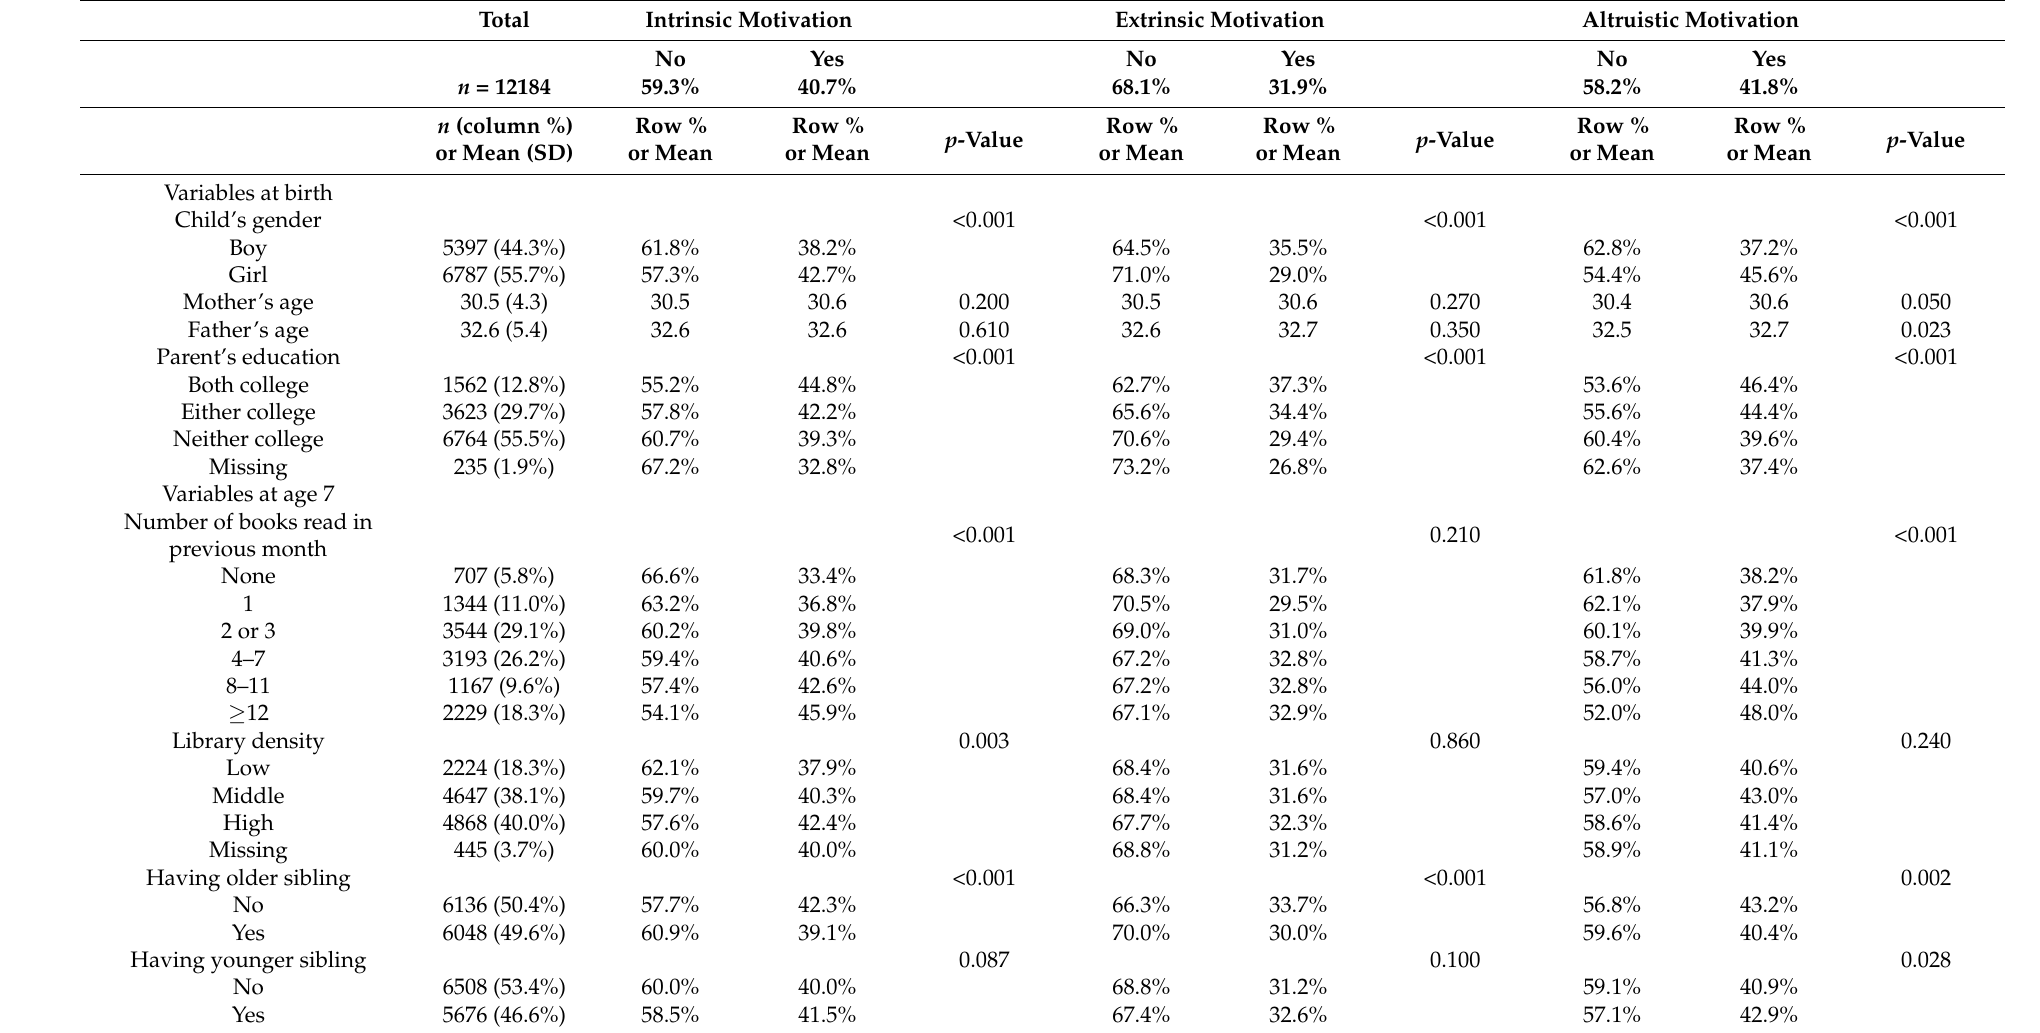
Table 1. Demographic characteristics of the study respondents ( n =